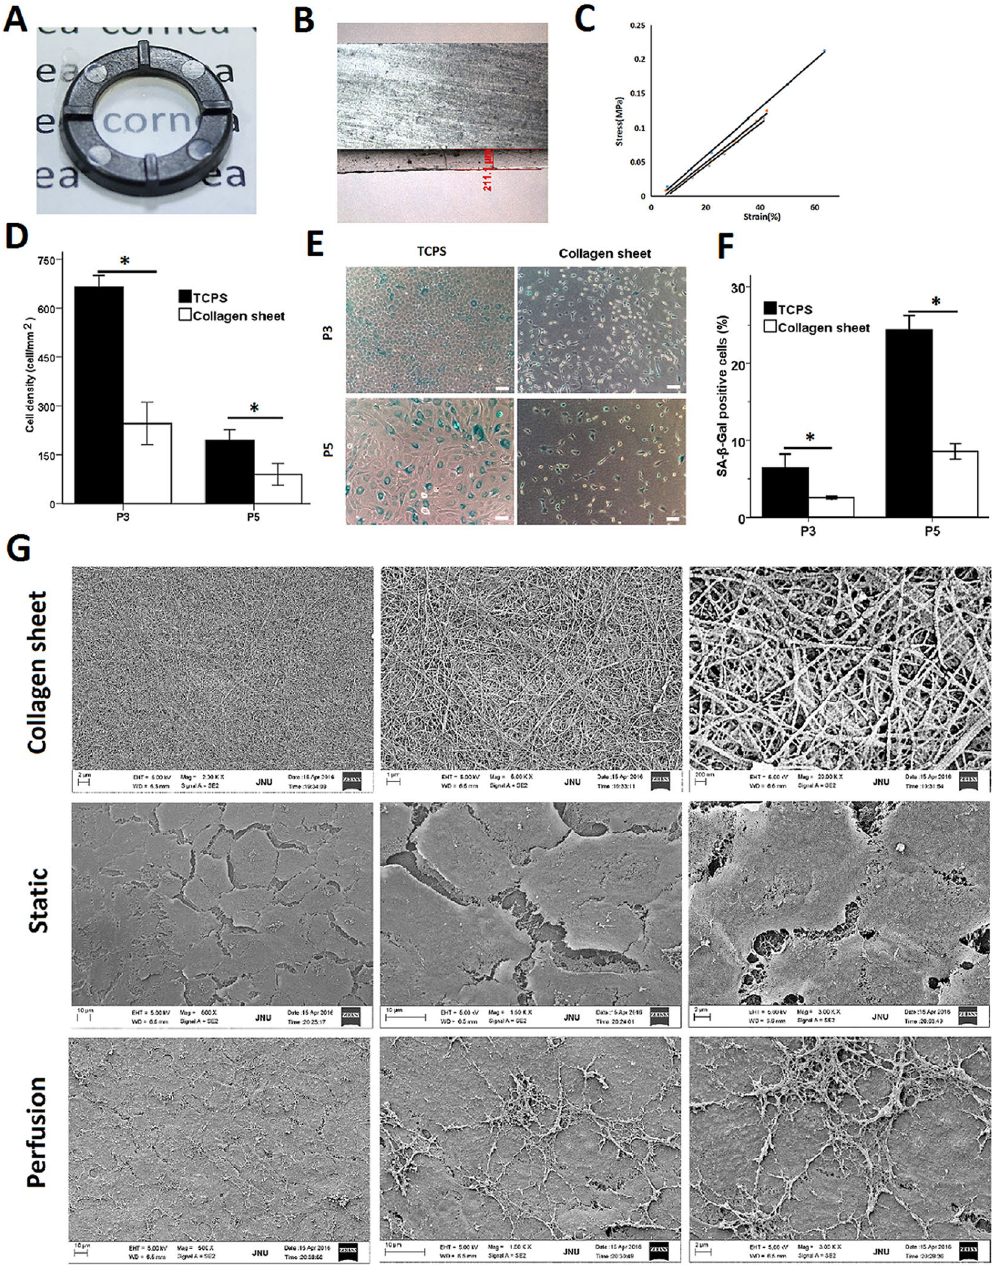
Figure 7. Characterization of the flat collagen sheet and the perfusion system for corneal tissue engineering. ( A ) Photograph of a flat collagen sheet. ( B ) Representative section of the collagen sheet. ( C ) Tensile stress- strain curve for each sample. ( D ) Cell density was calculated based on the total number of cells in each square millimetre. ( E ) Cells at different passages on TCPS and on collagen sheets were stained to detect SA- β -Gal activity. Scale bar: 100 μ m. ( F ) The senescence level of the CECs was evaluated based on the ratio of SA- β -Gal- positive cells to total cells. ( G ) SEM images of the collagen sheet prepared under vitrification conditions and representative images of CECs on collagen sheets in static and perfusion culture. Differences with * P < 0.05 were considered statistically